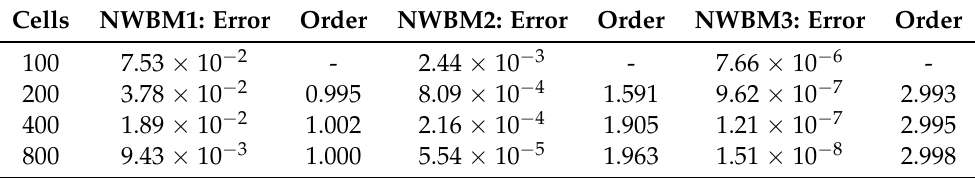
Table 2. Test 1.1. Differences in L 1 -norm with respect to the stationary solution and convergence rates for NWBM i , i =